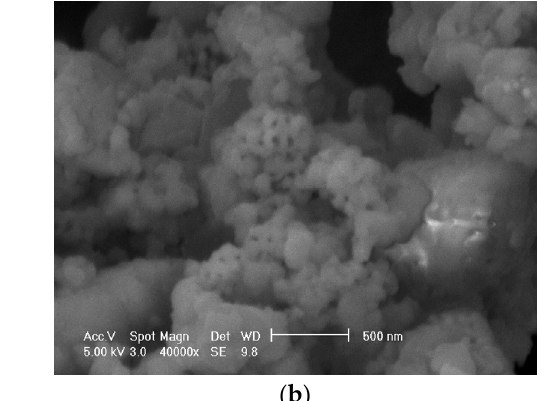
Figure 2. SEM images of SF and ground RHA: ( a ) SF; ( b ) FRHA (30 min grinding).